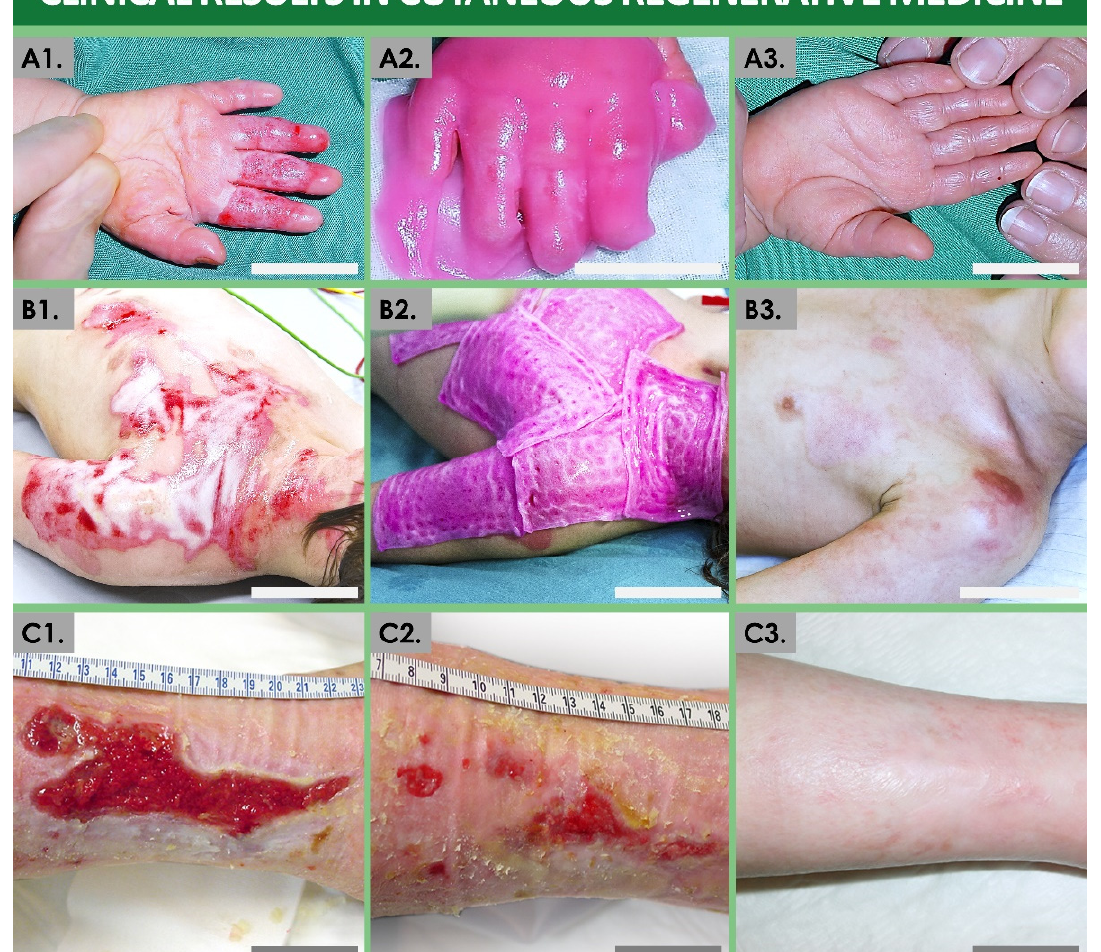
Figure 2. Illustrative overview of obtained clinical results using homologous skin progenitor cell-based PBBs in Swiss allogeneic cutaneous regenerative medicine. ( A ) Second-degree and third-degree pediatric hand burn wound (i.e., caused by scalding liquid). Photographic representations of the lesions after early debridement ( A1 ), after PBB application ( A2 ), and after six weeks of treatment ( A3 ). Scale bars = 2 cm. ( B ) Second-degree deep pediatric torso burn wound (i.e., caused by scalding liquid). Photographic representations of the lesions after early debridement ( B1 ), after PBB application ( B2 ), and after six weeks of treatment ( B3 ). Scale bars = 5 cm. ( C ) Refractory and painful post-thrombotic cutaneous ulcer lesions treated weekly using PBBs. Photographic representations of the lesions at the time of the treatment initiation ( C1 ), 11 weeks later ( C2 ), and 15 months later during follow-up monitoring ( C3 ). Scale bars = 4 cm. PBB, progenitor biological bandage. Modified and adapted with permission from Laurent et al., 2020 [18].